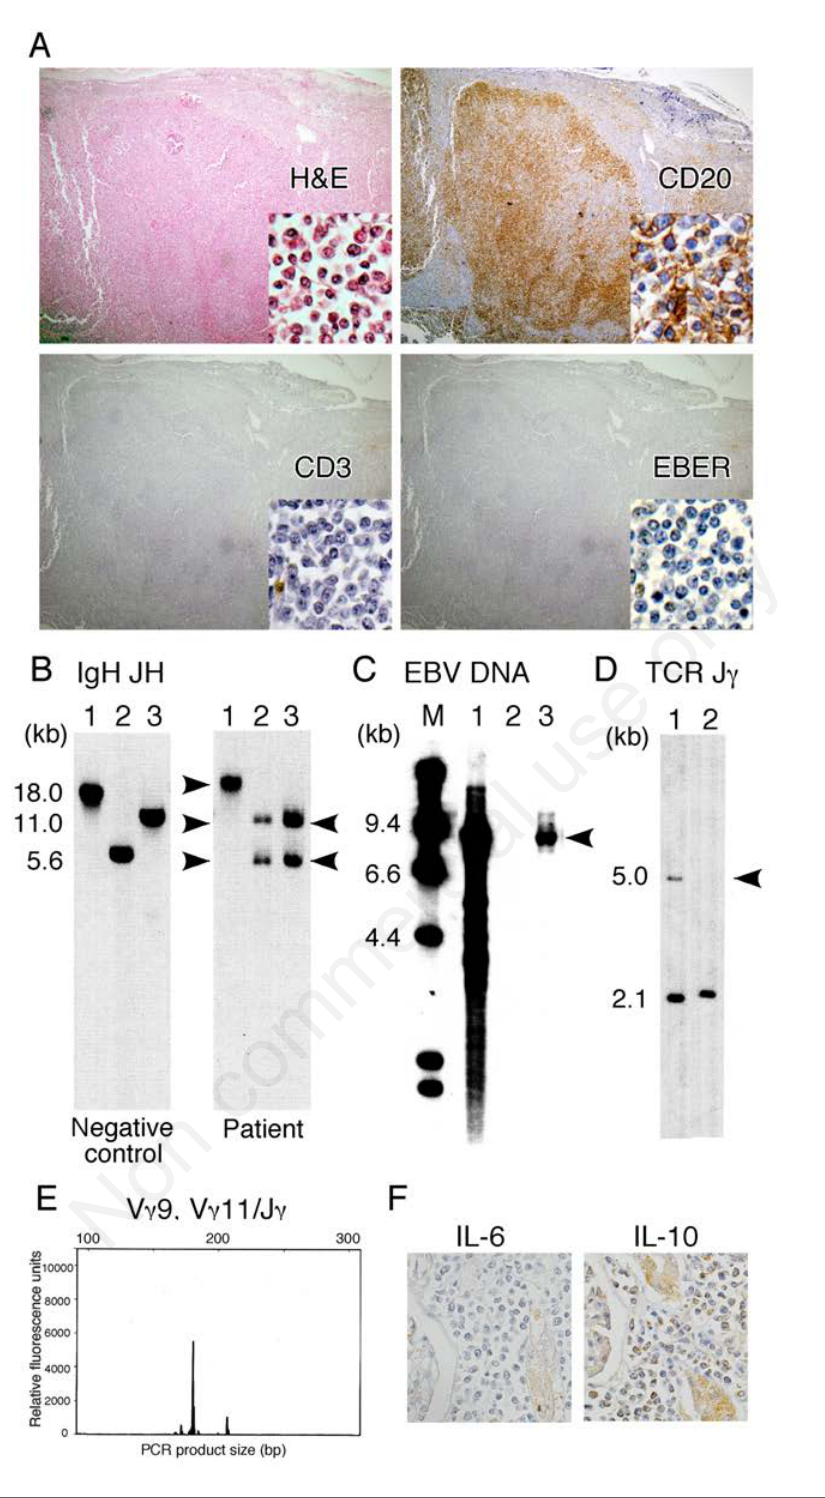
Figure 2. EBV-negative oligoclonal B-LPD, the clonal proliferation of T cells, and EBV following ATG therapy. (A) Histochemical staining of an abdominal lymph node (100×). Inset right below for each panel was a high magnification image (400×). H&E, staining with hematoxylin and eosin; EBER, FISH of EBV-encoded RNA. (B-D) Southern blot analysis of DNA extracted from LPD lesions. Blots were hybridized with the IGH gene probe JH (B), EBV-specific DNA probe Bam HIW (C), and TCR gene probe J g (D). Arrows indicate rearranged bands. In panel B, DNA was digested with the restriction enzymes Bam HI (lane 1), both Bam HI and Hind III (lane 2), and Hind III (lane 3). In panel C, DNA was digested with Bam HI: lanes 1 and 2, positive and negative controls for EBV, respectively; lane 3, LPD lesion. Lane M, DNA molecular weight markers. In panel D, DNA was digested with Hind III: lane 1, lym- phocytes of a healthy control; lane 2, LPD lesion. The arrow indicates a missing 5-kb fragment (TCR rearrangement). (E) Capillary electrophoresis of PCR products from the LPD lesion exhibiting T-cell clonality when assessed by TCR g rearrangement. (F) Immunohistochemical detection of IL-10 and IL-6 in the kidney showing the marked infiltration of